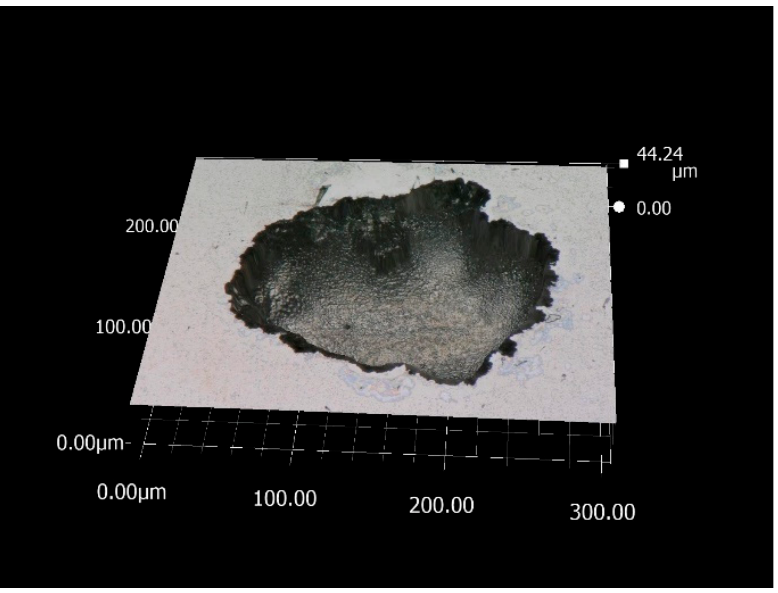
Figure 10. Optical micrograph of pitting pits on the polished samples surface.